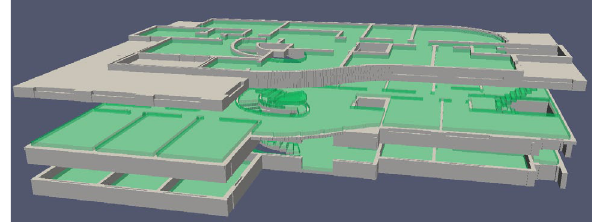
Fig 9: Navigable space as the largest connected component in the air layer just above floors and stairways To continue the navigation process, we selected one destination voxel near the main building entrance, and another using the emergency exit at the right front side of the building. The two resulting distance fields, denoting the distances from anywhere in the building to the nearest destination voxel, are shown in Fig. 10. Next, specific voxels can be selected as starting points to compute routes to the nearest of the exits, by floating downward through the distance fields.